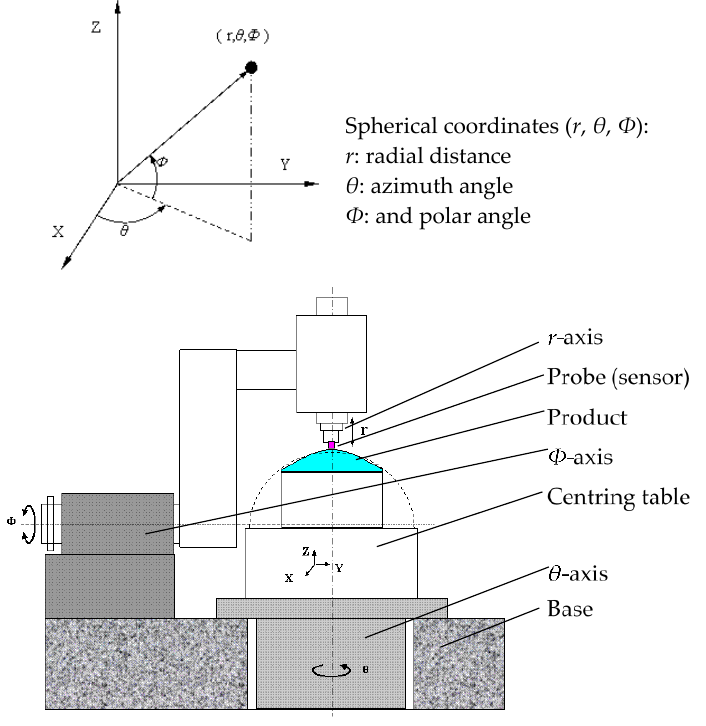
Figure 2. Schematic of spherical coordinate machine used for asphere surface measurement.